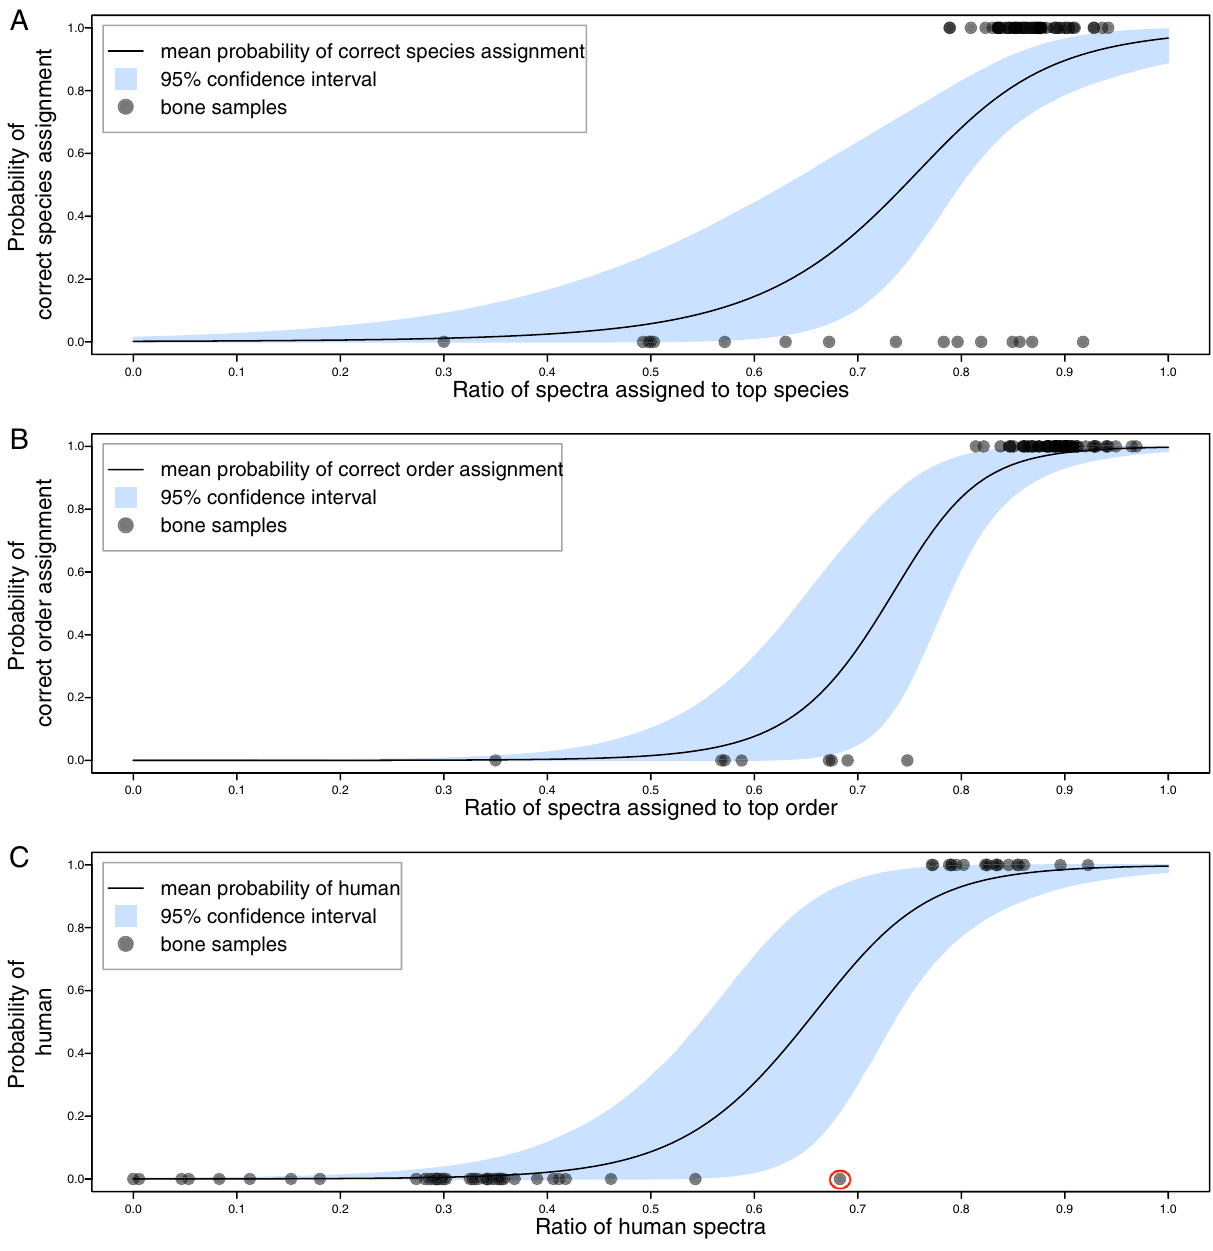
Figure 8. Models of correct species, order and human identifications. Logistic regression models shown in ( A – C ) are generated using all available sample data in order to illustrate posterior probability distributions for a range of possible spectra ratios. ( A ) Logistic regression model for probability of correct species identification using spectra ratio, trained on mammalian bone samples of known species and all non-mammal bone samples using a mammalian database. Ratios of correctly identified samples are at y = 1, misidentified samples at y = 0. Mean probability of correct species identification at all possible spectra ratios (0–1) is shown within a 95% confidence interval. ( B ) Logistic regression model for probability of correct order identification using spectra ratio, trained on mammalian bone samples of known order and all non-mammal bone samples using a non- mammalian database. Ratios of correctly identified samples are at y = 1, misidentified samples at y = 0. Mean probability of correct order identification at all possible spectra ratios (0–1) is shown within a 95% confidence interval. ( C ) Logistic regression model for probability of human identification using spectra ratio, trained on known human and non-human bones samples searched against a vertebrate database and ratios of human assigned spectra to total spectra determined. Ratios of human samples are at y = 1, non-human samples at y = 0. Mean probability of human identification at all possible human spectra ratios (0–1) is shown within a 95% confidence interval. The one non-human primate tested (rhesus monkey, Macaca mulatta ) had a human spectra ratio of 0.68, showing clear separation of Macaca from human samples (circled